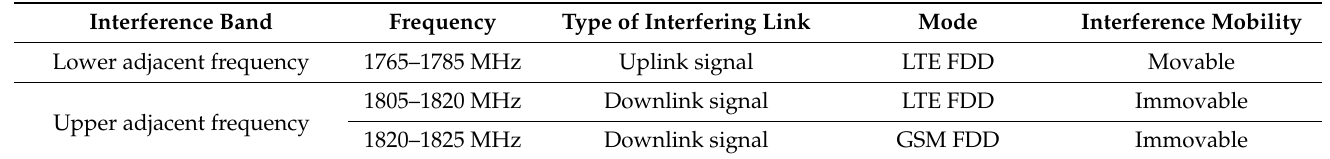
Table 1. LTE-M band with upper and lower adjacent frequency